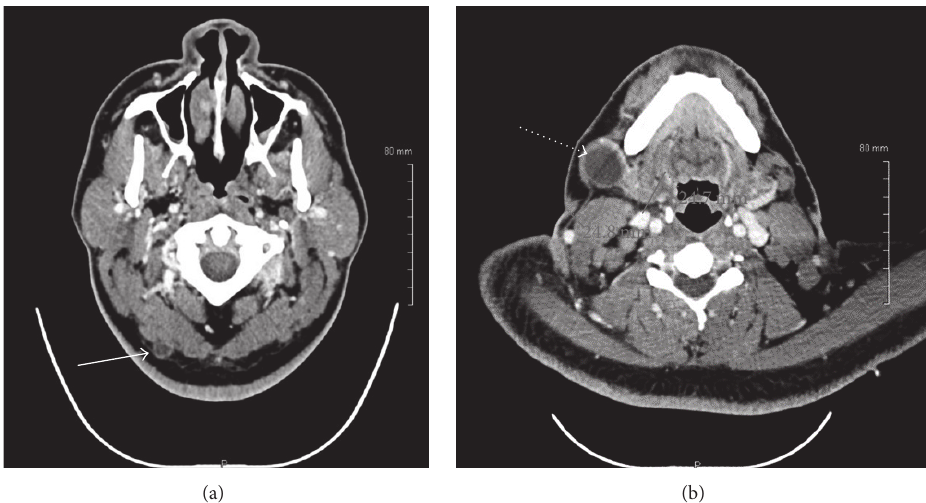
Figure 3: Computed Tomography (CT) scan of soft tissue neck demonstrating right occipital (solid arrow) and right jugulomandibular (dotted arrow) cervical